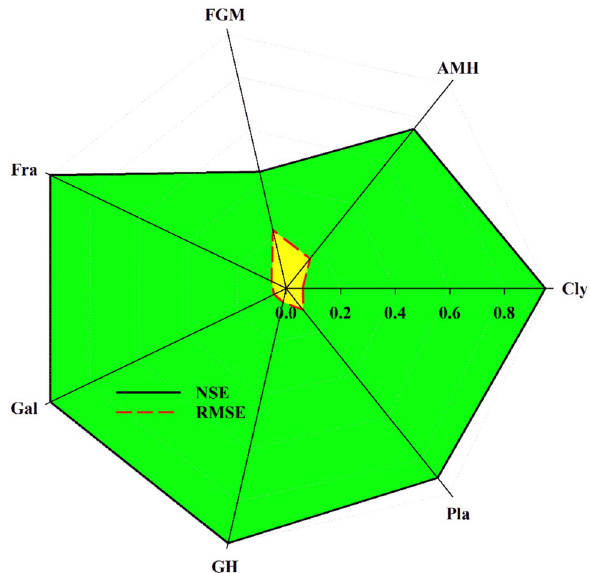
Fig. 7 NSE and RMSE evaluation statistics result for selecting the best copula with a discharge of 28.8